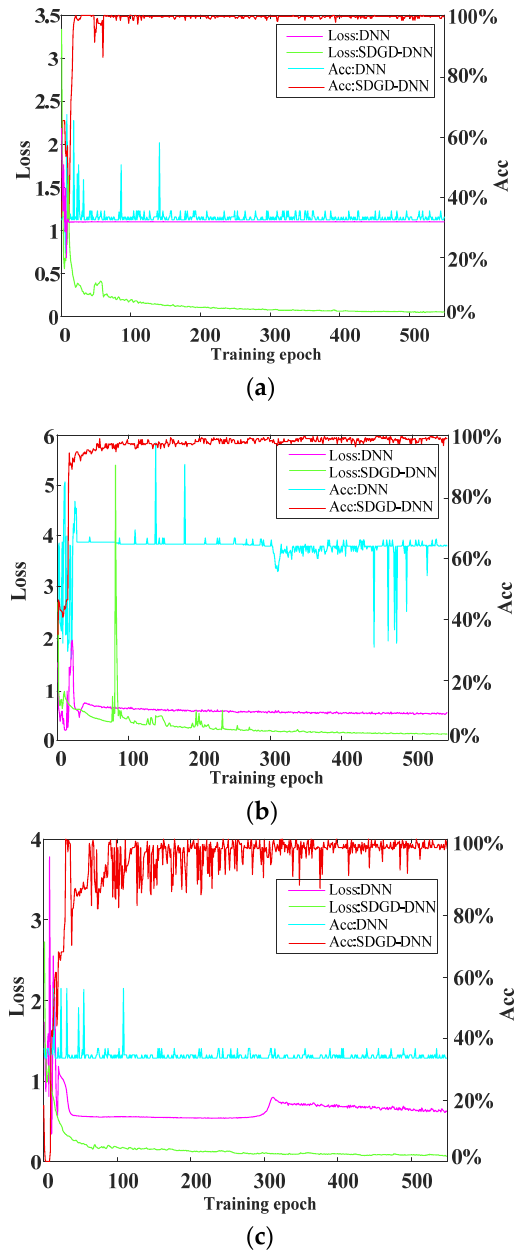
Figure 13. Convergence speed comparison ( a ) rng(4) ( b ) rng(200) ( c ) rng(258).